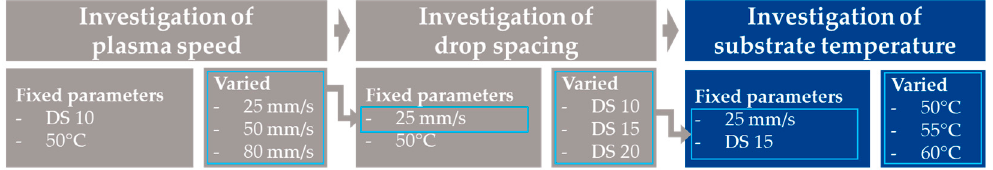
Figure 11. Fixed and varied process parameters for the investigation of substrate temperature.